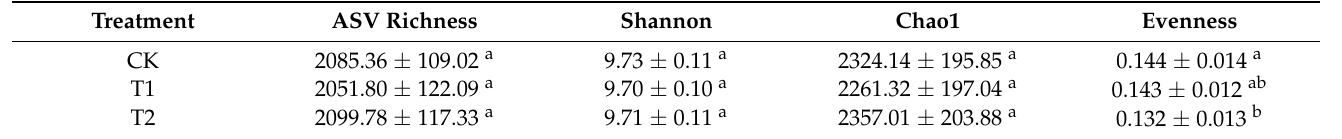
Table 2. Effects of MPs on the diversity of bacteria community.